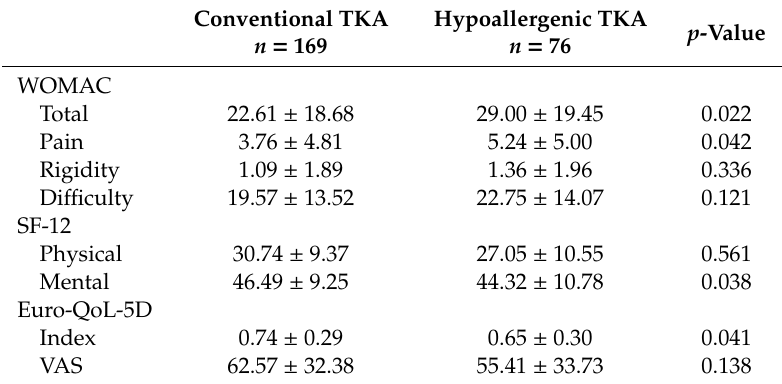
Table 4. Results of the ANCOVA statistical analysis for the two study groups (conventional and Euro-Qol-5D) after pairing the patients by age, sex, weight, previous psychiatric history and associated complications. The results are presented as the mean ± standard deviation (SD).